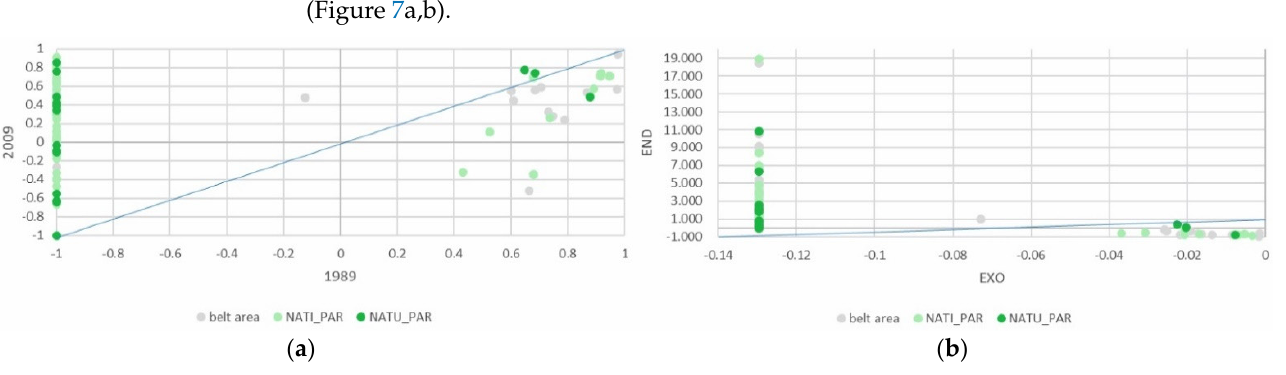
Figure 7. ( a , b ) Sierra Nevada- PSI and DPSI for family vegetable gardens. Source: Drawn up by the authors using data from the 1989 and 2009 Agrarian Censuses, Ministry of Agriculture.